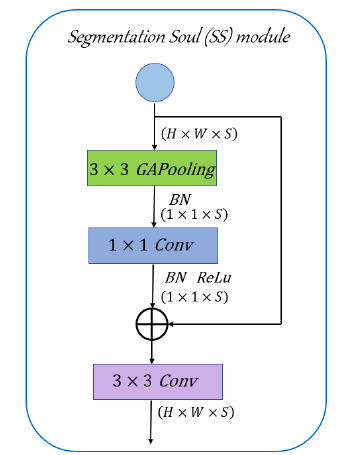
Figure 4. Detailed design of the SS. GAPooling is the global average pooling. Conv is the convolu- tional operation. BN denotes batch normalization. ReLu is the ReLu activation function. Simulta- neously, 1 × 1, 3 × 3, indicates the kernel size and H × W × S represents the tensor shape (height, width,